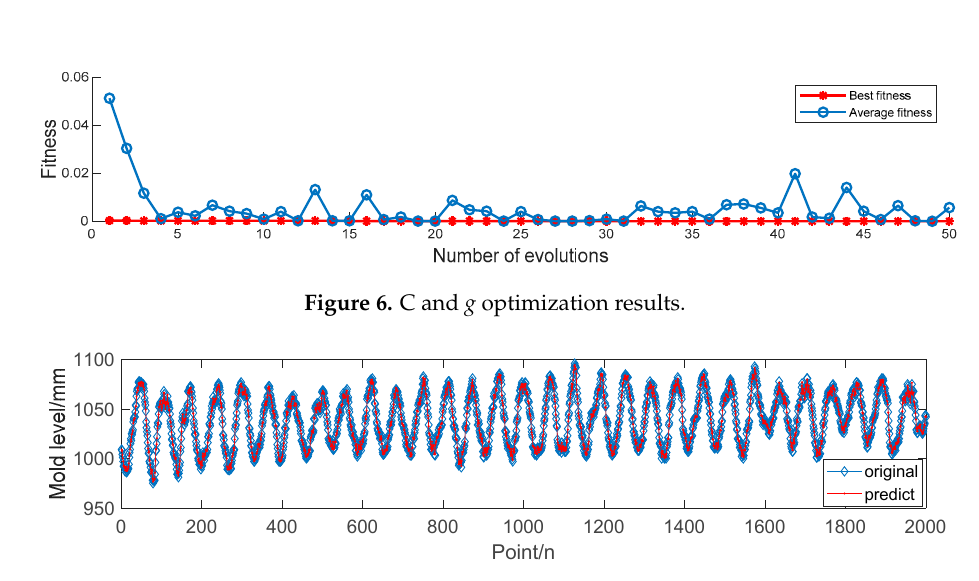
Figure 7. Comparison of EMD-SVR prediction results with original mold level data.